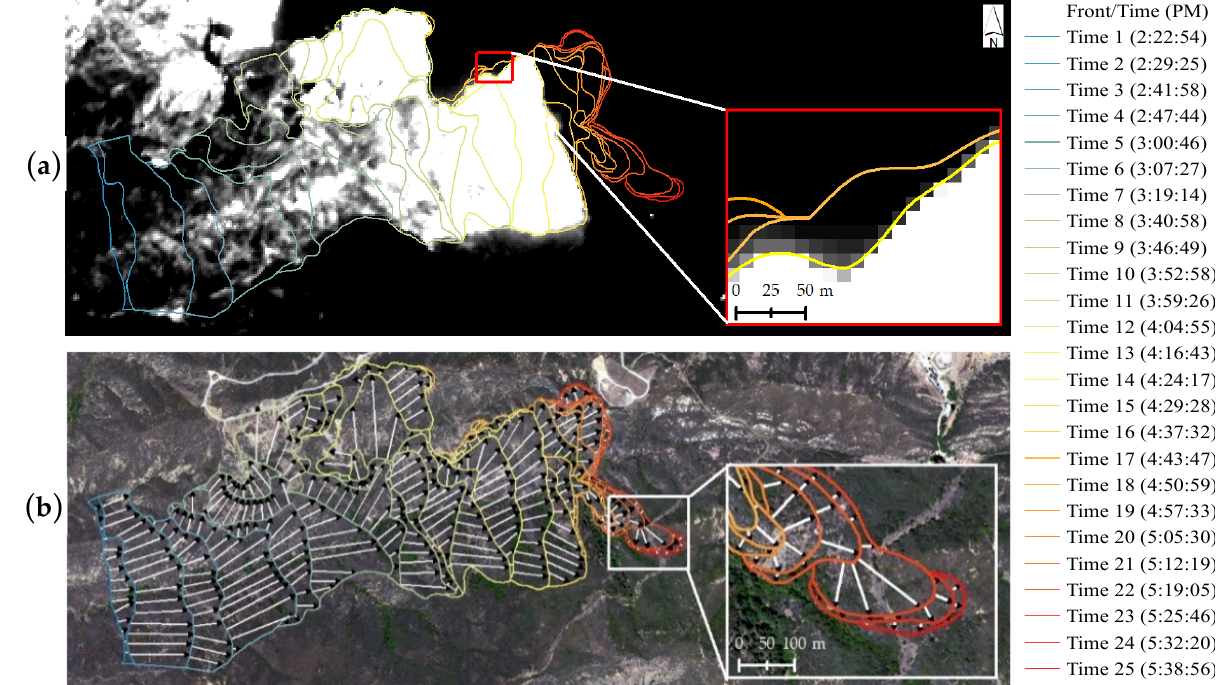
Figure 2. Fire front delineation and fire spread vector/LSUs for Thomas Sequence 2. ( a ) Fire fronts overlaid on contrast- enhanced pass-15 thermal infrared (TIR) image. Inset map depicts from location relative to TIR pixel gradient; ( b ) fire spread vectors and LSUs with fire fronts overlaid on National Agriculture Imagery Program (NAIP) orthoimagery. The average time between successive fire fronts for Thomas 2 was 8:24 (min).